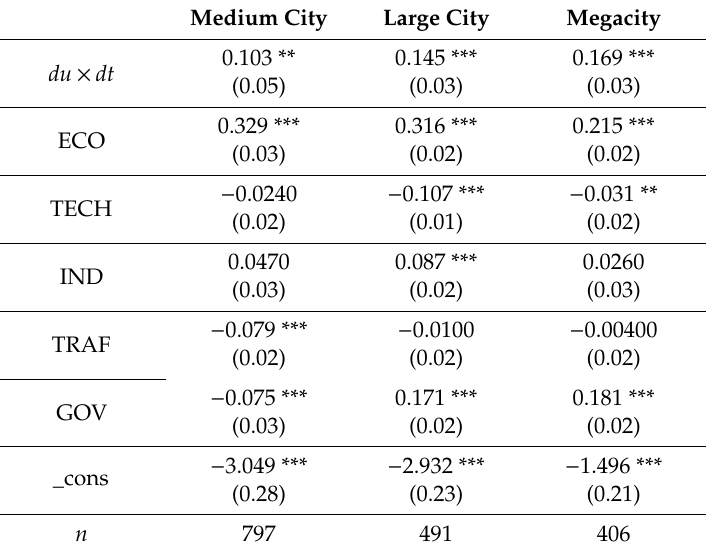
Table 6. Regression results of di ff erent city